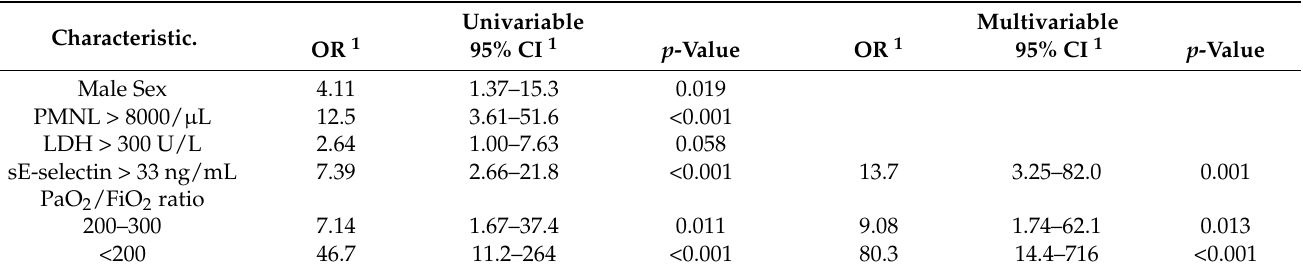
Table 4. Risk factors associated with ICU admission.